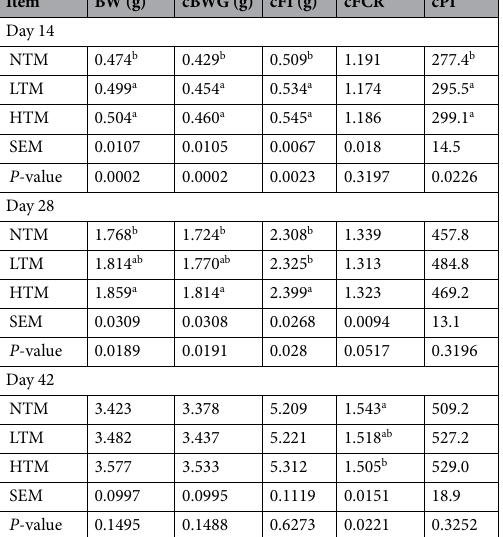
Table 3. Growth performance at 14, 28 and 42 d of age of broilers fed three supplemental trace mineral levels. a,b Means within a column with different superscripts differ at P < 0.05. Reported standard error of the mean (SEM) is the average SEM of the individual least-square means.